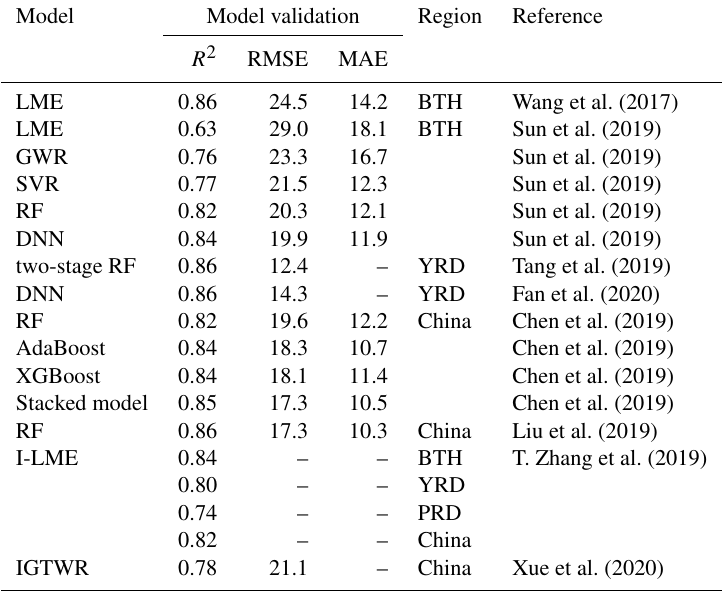
Table 6. Comparison of model performances from previous studies in estimating hourly PM 2 . 5 concentrations in